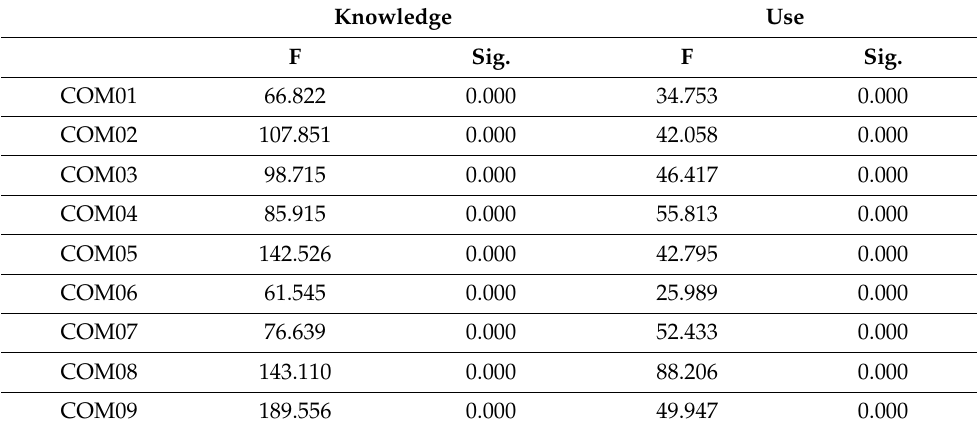
Table A15. ANOVA: knowledge and use of communication tools.